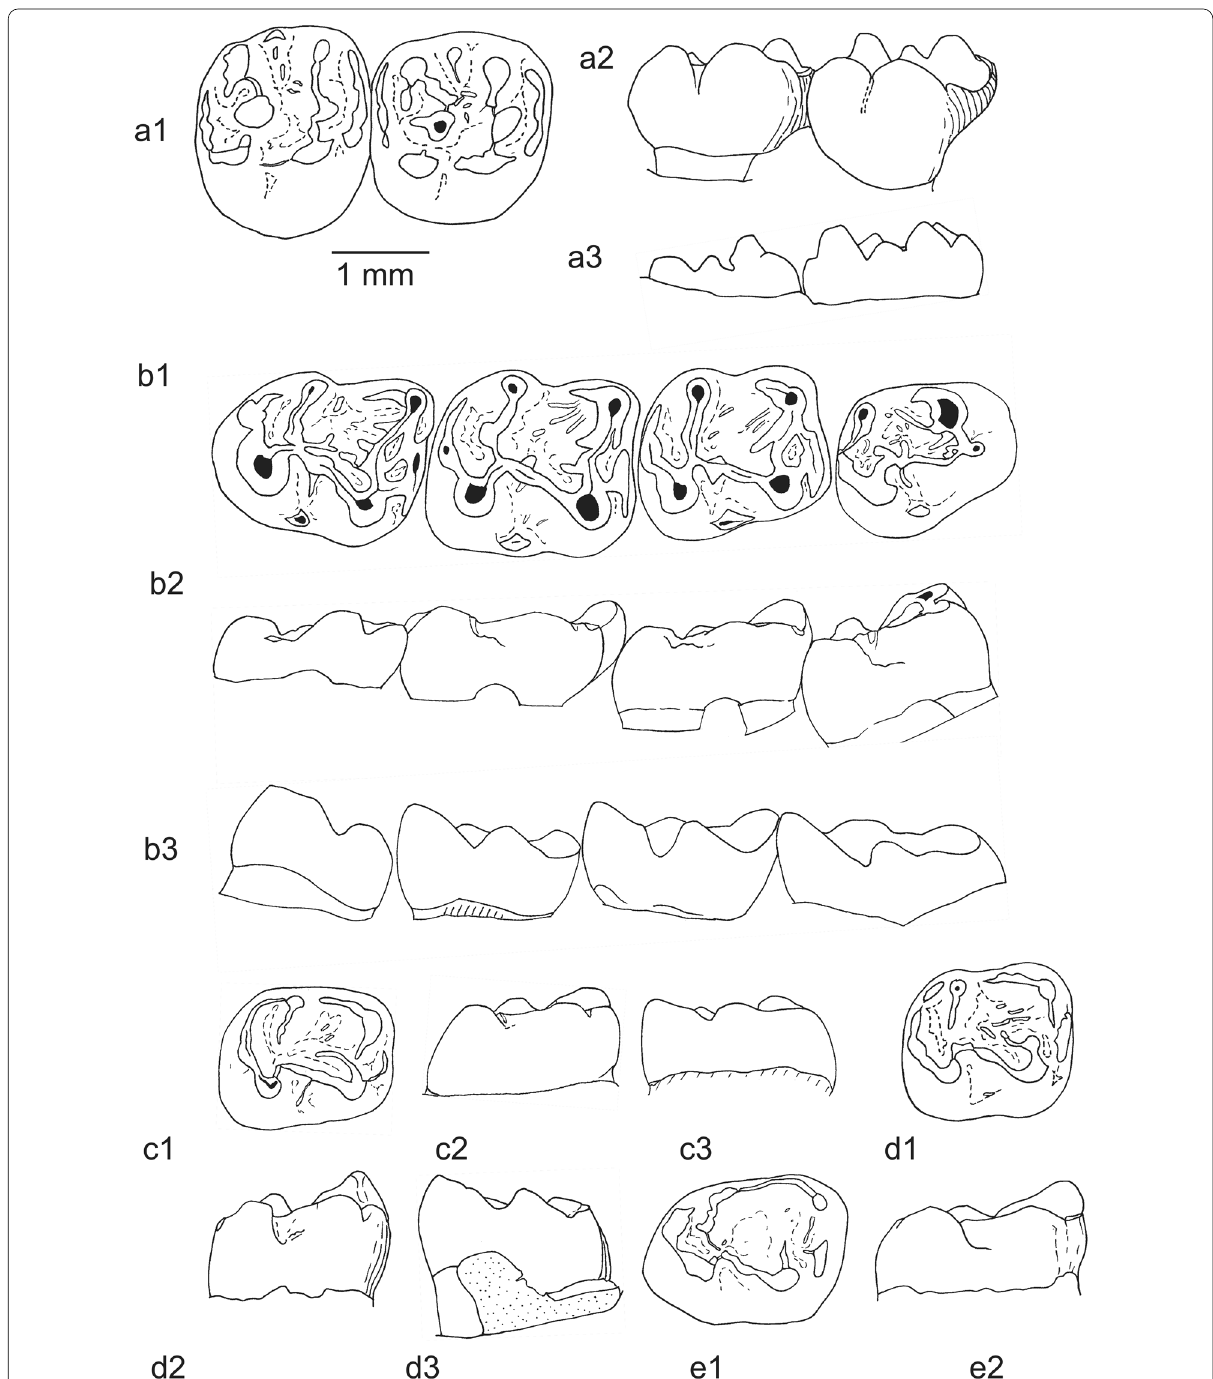
Fig. 20 Lower teeth of Protadelomys lugdunensis Hartenberger, 1969, from Egerkingen (Swiss Jura). a Ek 592, right P4–M2; a1, occlusal view; a2, lingual aspect; a3, buccal aspect. b Em 21, left right tooth row with p4–m3; b1, occlusal view; b2, buccal aspect; b3, lingual aspect. c : Ek 126, right m1, weakly worn; c1, occlusal view; c2: buccal aspect; c3: lingual aspect. d Ek 71, right m2, weakly worn; d1, occlusal view; d2: buccal aspect; d3: lingual aspect. e Ek 72, right m3, weakly worn; e1, occlusal view; e2: buccal aspect. Scale bar